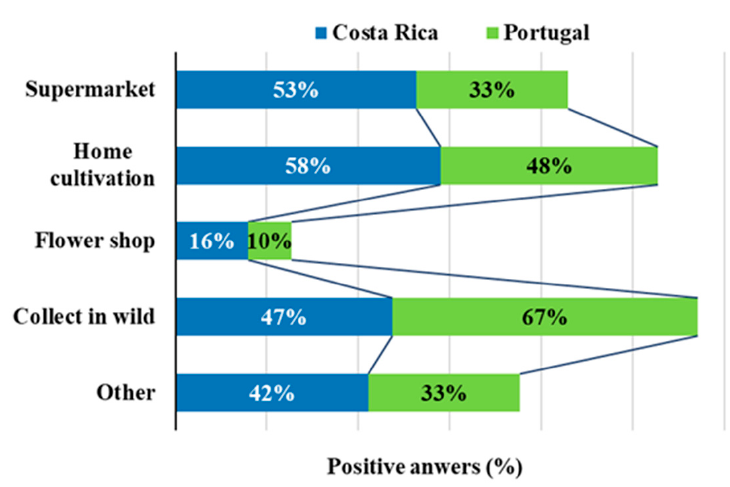
Figure 6. Places where the participants buy EF.